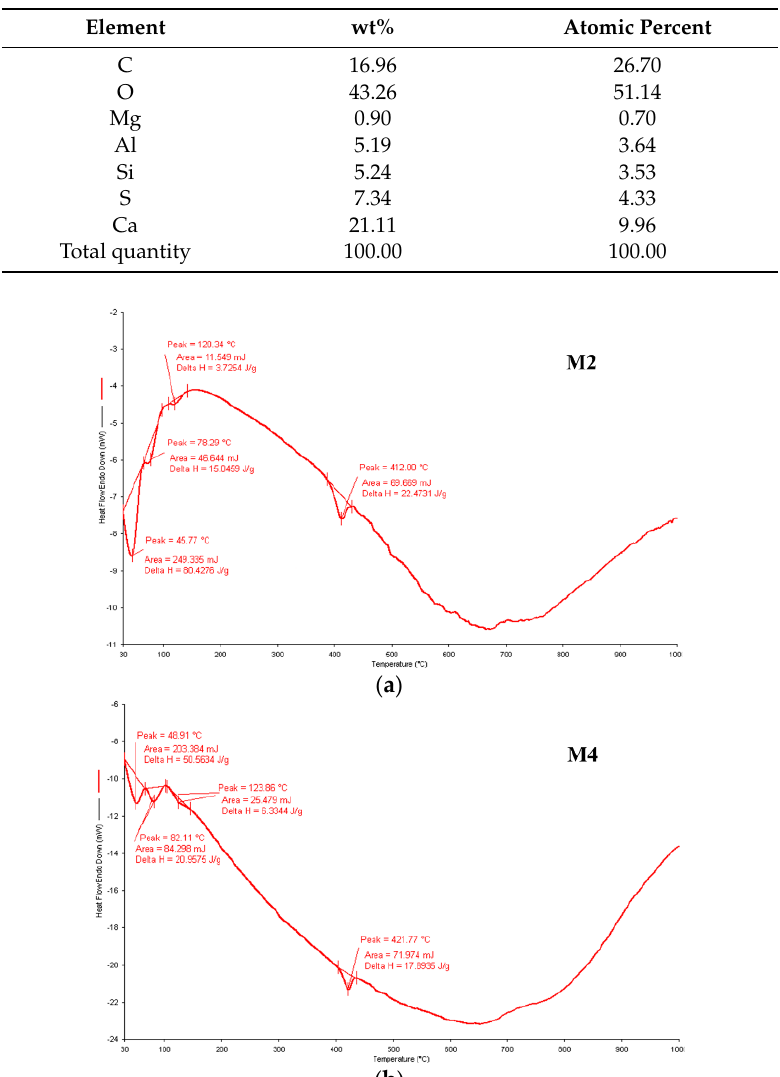
Figure 8. SEM images of the M4 specimen at 28 days. ( a ): 28 days; ( b ): EDS of the spot under the red block in ( a ). Table 3. Crystal elements in SAR specimen M4.